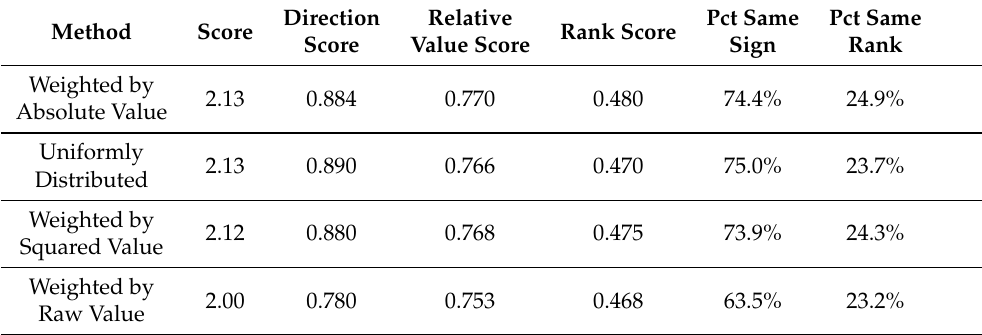
Table A1. Results from additional simulations encompassing different numbers of variables and different variable